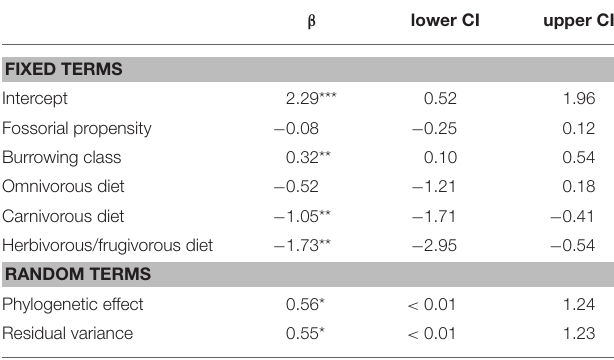
TABLE 4 | Relationship between social class, fossoriality and diet in the